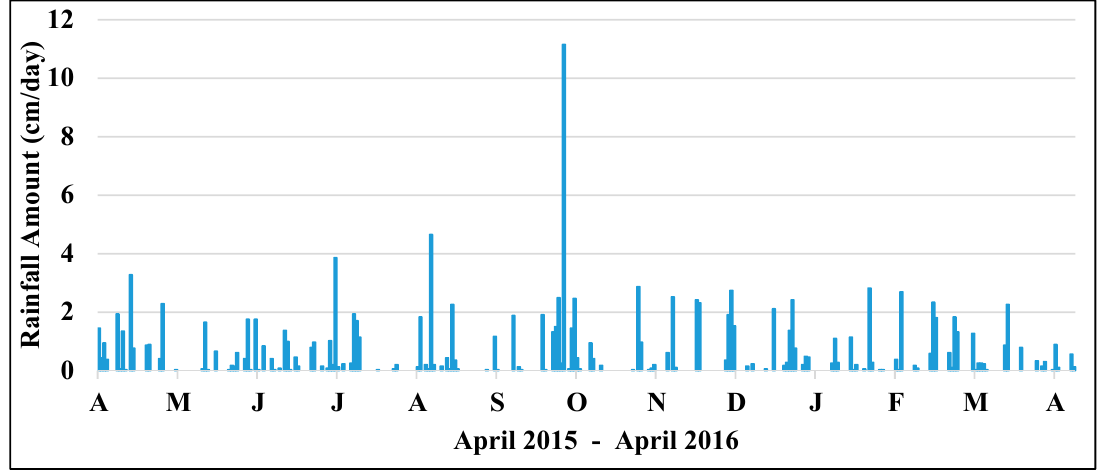
Figure 2. Daily rainfall amounts over the course of 1 year of data collection.